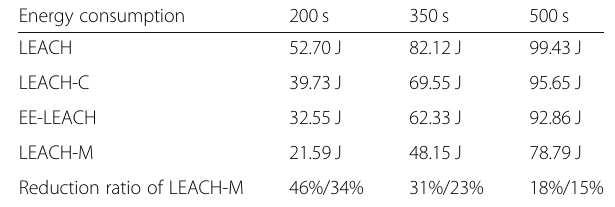
Table 3 The statistics of alive nodes of four algorithms in 100 × 100m